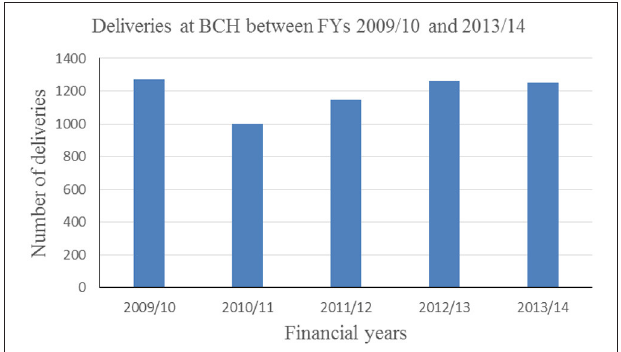
FIGURE 3 | Deliveries at BCH for the financial years 2009/10 to